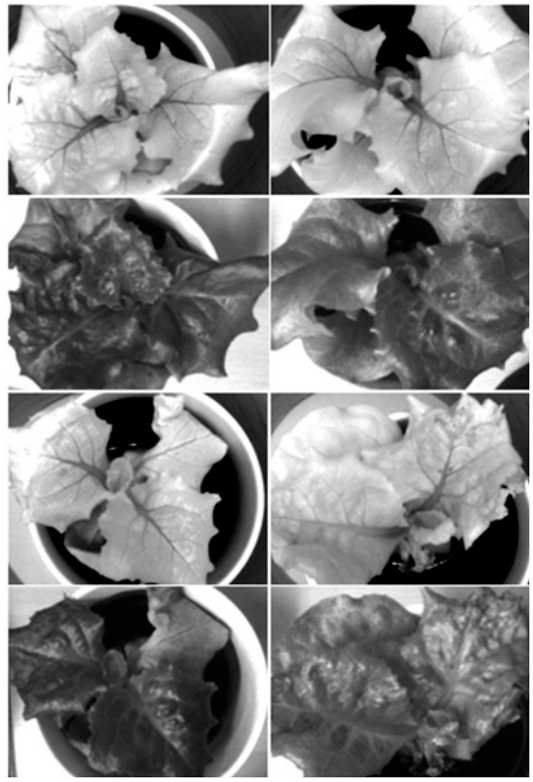
Figure 7. Actual example of image acquisition.